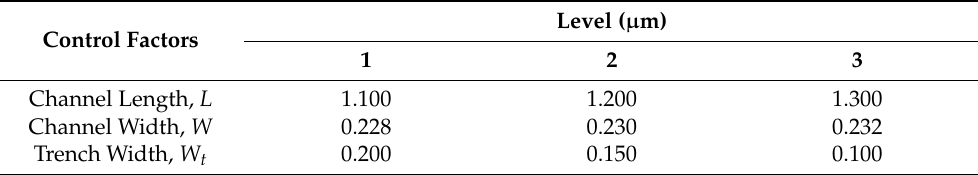
Table 1. Control factors and their level parameters selected from analysis of individual parameters and their electrical performance.